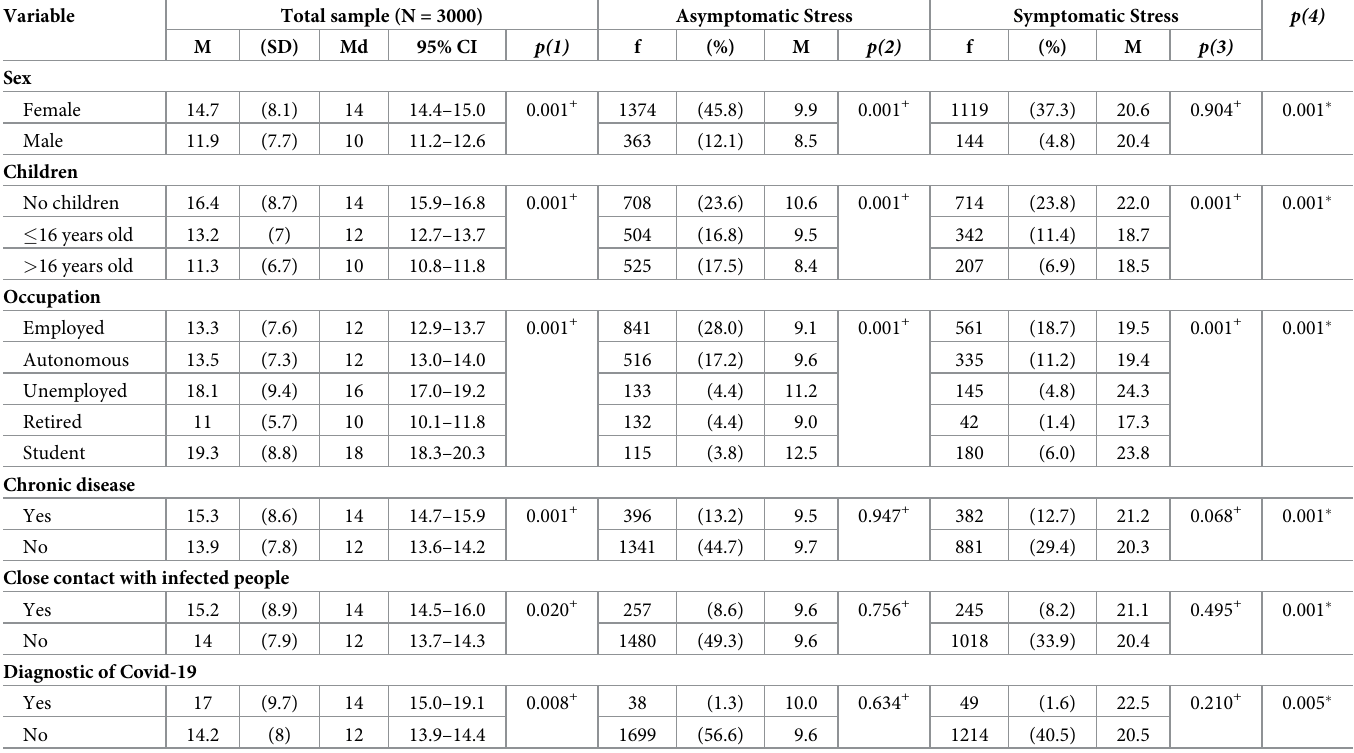
Table 5. Comparison of symptomatic and asymptomatic groups for stress.